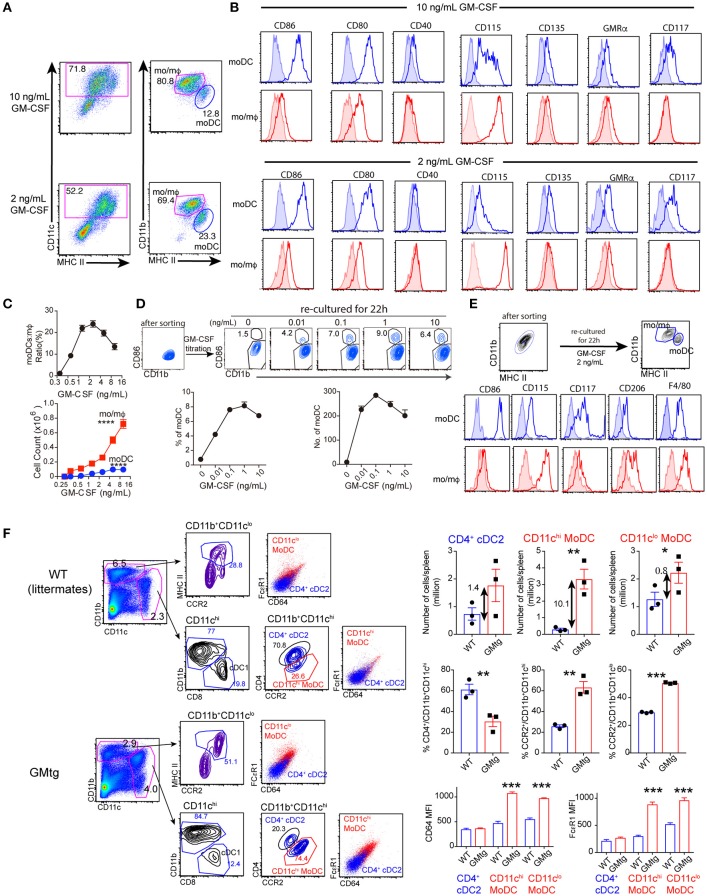
The effect of GM-CSF dose on the differentiation of mo/mΦ and moDCs. (A–C) BM cells were cultured with different dose of GM-CSF for 7 days. Cultures were harvested and analyzed for cell composition. (A). Gating strategy for mo/mΦ and moDCs characterization in current study. (B) moDCs and mo/mΦ from gated Ly6GloCD11c+MHCII+ population are shown for expression of additional markers. Shade area show FMO controls for gated population. (C) The ratio of moDCs to mo/mΦ and absolute number of recovered moDCs and mo/mΦ in the cultures with different doses of GM-CSF were plotted. ****p < 0.0001 (ANOVA). Data are from one of 3 repeated experiments. (D) After culturing with 10 ng/mL GM-CSF for 7 days in vitro, mo/mΦ were purified by flow sorting and then re-cultured with different doses of GM-CSF for 22 h. The percentage and number of recovered DCs are shown. (E) After culturing with 10 ng/mL GM-CSF for 7 days in vitro, sorted mo/mΦ were re-cultured with 2 ng/mL GM-CSF for 22 h. Histograms show expression of different markers of monocytic myeloid cells. Shade area show FMO controls for gated population. (F). Spleen cells were prepared from CCR2.CFP.DTR mice (8–12 week female, n = 3) and CCR2.CFP.DTR/GMTg mice (8–12 week female, n = 3). FACS plots show distribution of moDCs and cDCs. Bar graphs show numbers, percentages and expression of CD64 and FcεR1 by DC subsets. Numbers in the plots show fold increase. *p < 0.05, **p < 0.01. ***p < 0.001 (student's t-test).